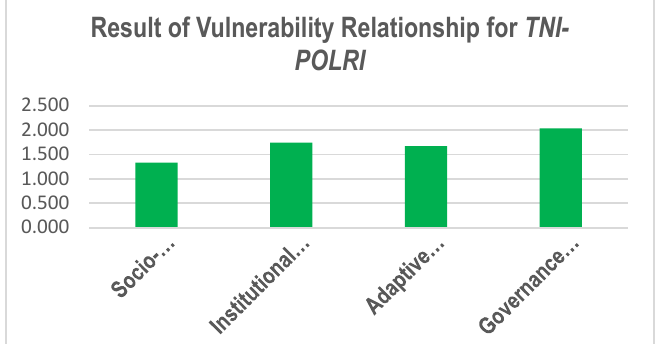
Fig. 5. Graph of Vulnerability evaluation scores for TNI-Polri power relations post-1998 reformation era.